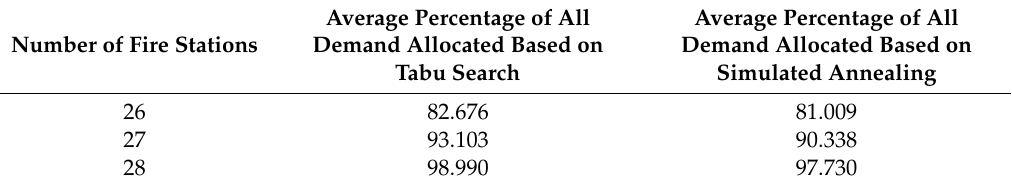
Table 25. The average percentage of all demand allocated using both algorithms.